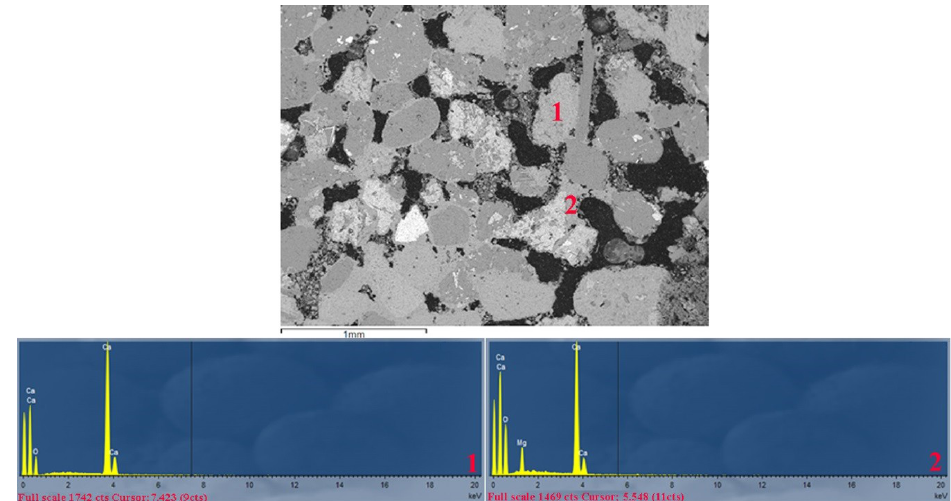
Figure 11. Secondary electron images (SEI) of beachrocks collected at area 1, indicating micritic cement in coexistence with halite and gypsum.